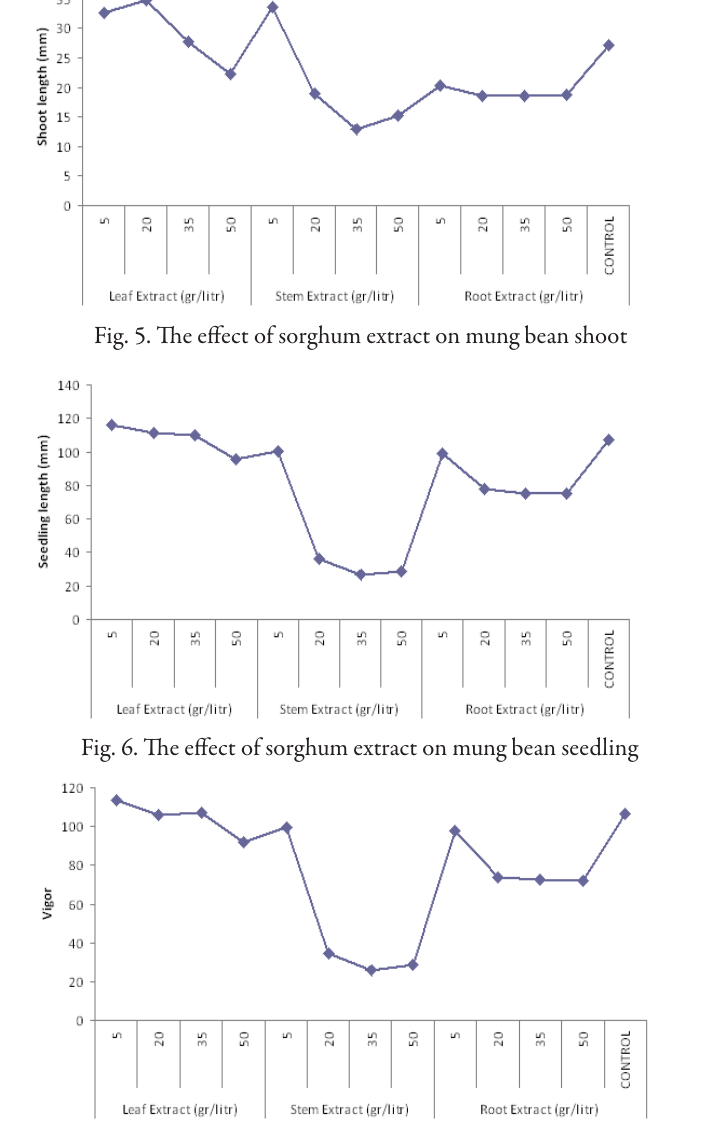
Fig. 7. The effect of sorghum extract on mung bean seed